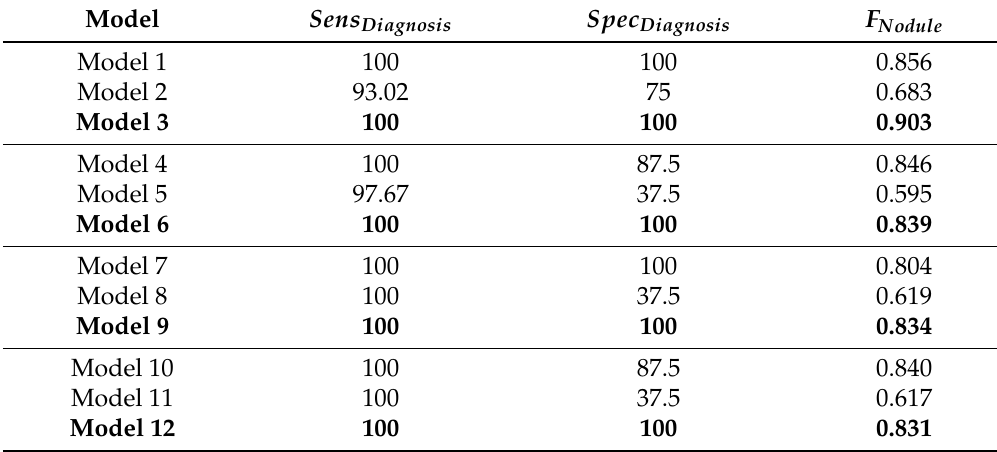
Table 8. Diagnosis scores of best